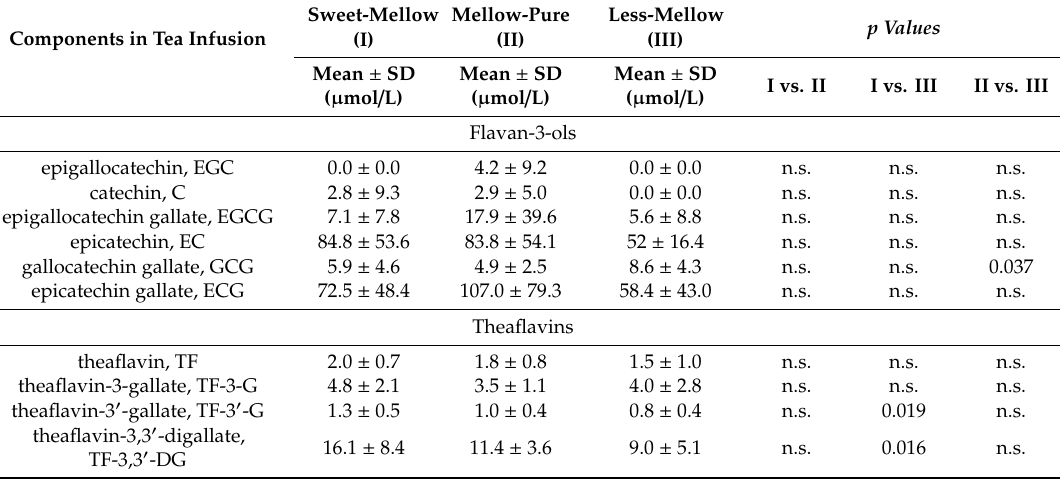
Table 2. Quantitative analysis and comparison of taste-active compounds among the sweet-mellow (I), mellow-pure (II), and less-mellow (III) black tea infusions. Data are presented as mean ± SD ( n = 11, 14, 8, respectively). Statistical significance was determined by one-way ANOVA through an LSD post-hoc test. n.s., not